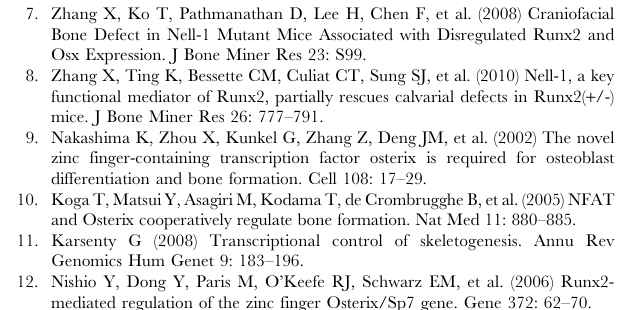
Figure 6. Osterix affects NELL-1 and some bone marker genes expression in Saos-2 cells (A) and primary human osteoblast (hOB) (B). Real time PCR analysis of Nell-1 , OCN and OPN transcripts in Saos-2 cells transiently transfected with Control (pCtr) or Osterix expression vector (pOsx) at 2 days and 7 days (top panel). The effects with transcient transfection of Negative control siRNA (NC-siRNA) or Osterix siRNA mixture (Osx- siRNA) were revealed by Real time PCR analysis at 2 days and 7 days (bottom panel). ( C ) Diagram of the regulatory relationship between Runx2, Osterix and NELL-1. Runx2 positively regulates Osterix and NELL-1. Osterix negatively controlled NELL-1 expression in this study. NELL-1 was also shown to positively affect Runx2 through phosphorylation and negatively feedback on Osterix during